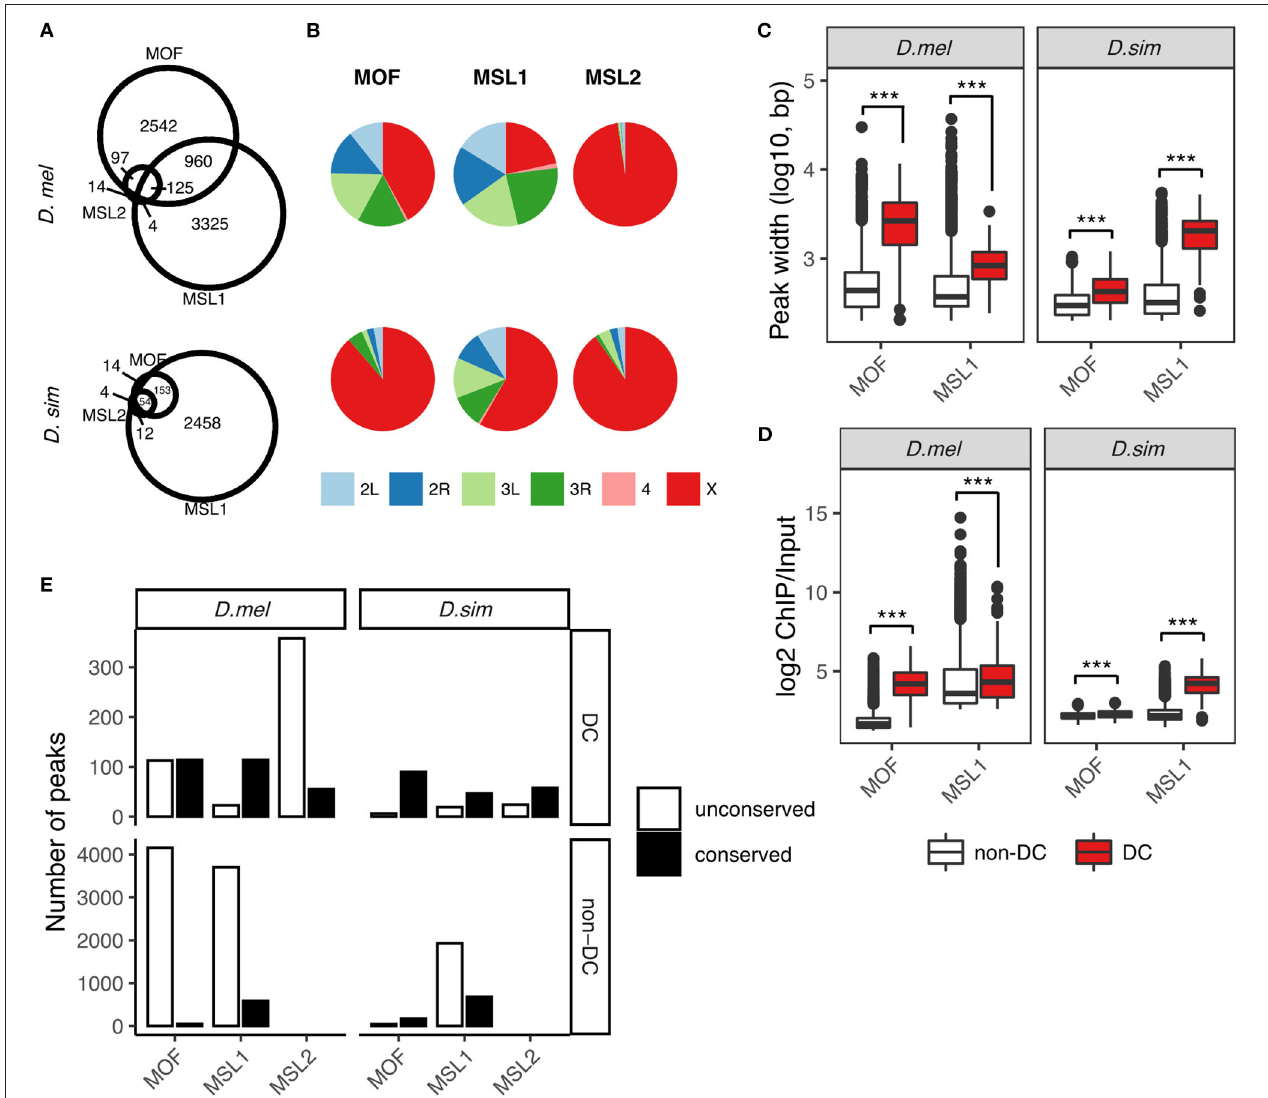
FIGURE 1 | Comparative analysis of MOF, MSL1, and MSL2 binding sites in D. melanogaster and D. simulans . (A) Overlaps between MOF, MSL1, and MSL2 binding sites. Numbers reflect merged binding sites (see Materials and Methods). (B) Chromosome distribution of MOF, MSL1, and MSL2 binding sites. Boxplot of binding peak widths (C) and binding affinities (D) of MOF and MSL1 regions involved in dosage compensation (DC, overlapping with MSL2) and unrelated functions (non-DC, non-overlapping with MSL2). Significance was determined by the Mann-Whitney U -test: *** P < 0.001. (E) Number of conserved DC and non-DC MOF/MSL1 sites in D. melanogaster ( D.mel ) and D. simulans ( D.sim